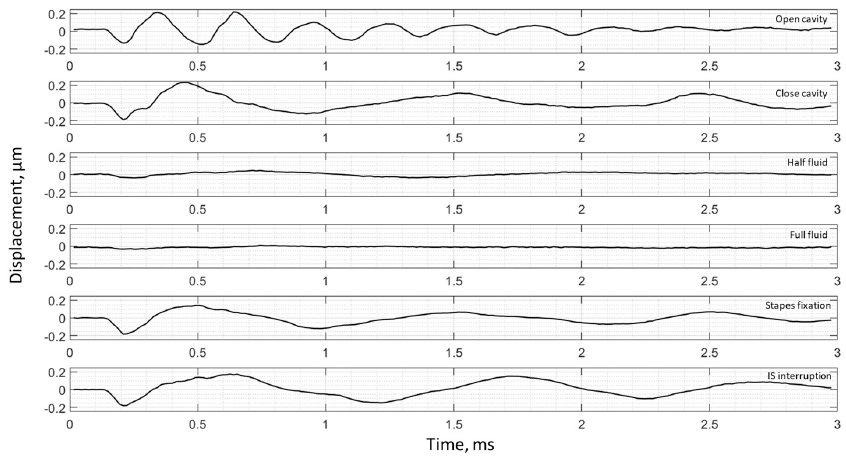
Figure 8. Umbo displacement of TB4 under different cases (umbo location is marked as the intersection of the solid black and dashed black lines in Figure 3b).